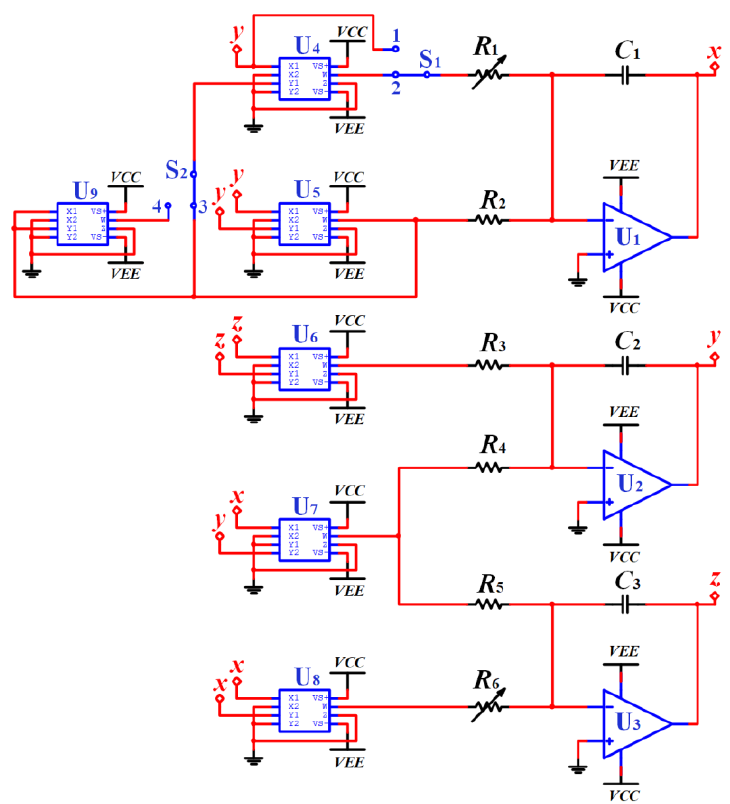
Figure 10. Circuit schematic of SL8I, SL8II and SL8III.